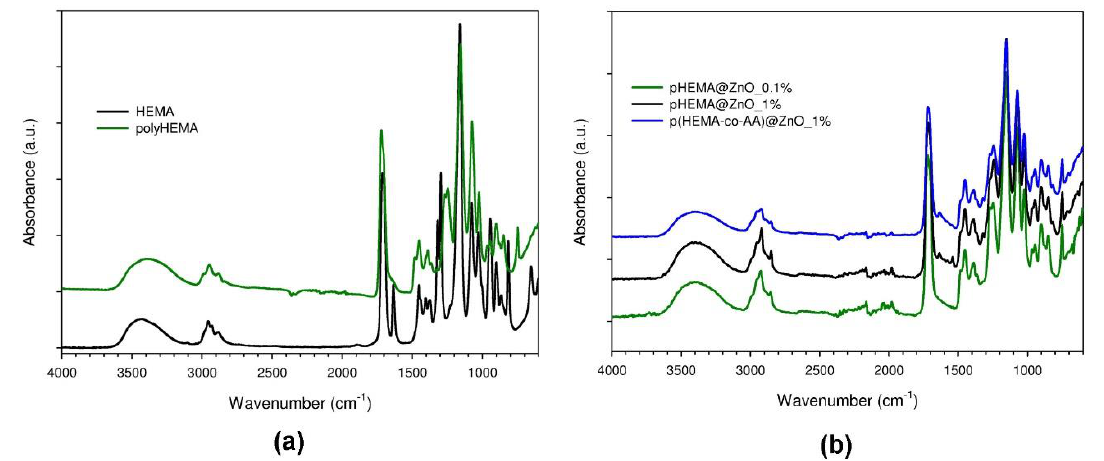
Figure 4. ( a ) FTIR spectra of HEMA monomer and of polyHEMA hydrogel obtained after radical polymerization; ( b ) Comparison of FTIR spectra of composite samples incorporating different percentages of ZnO.